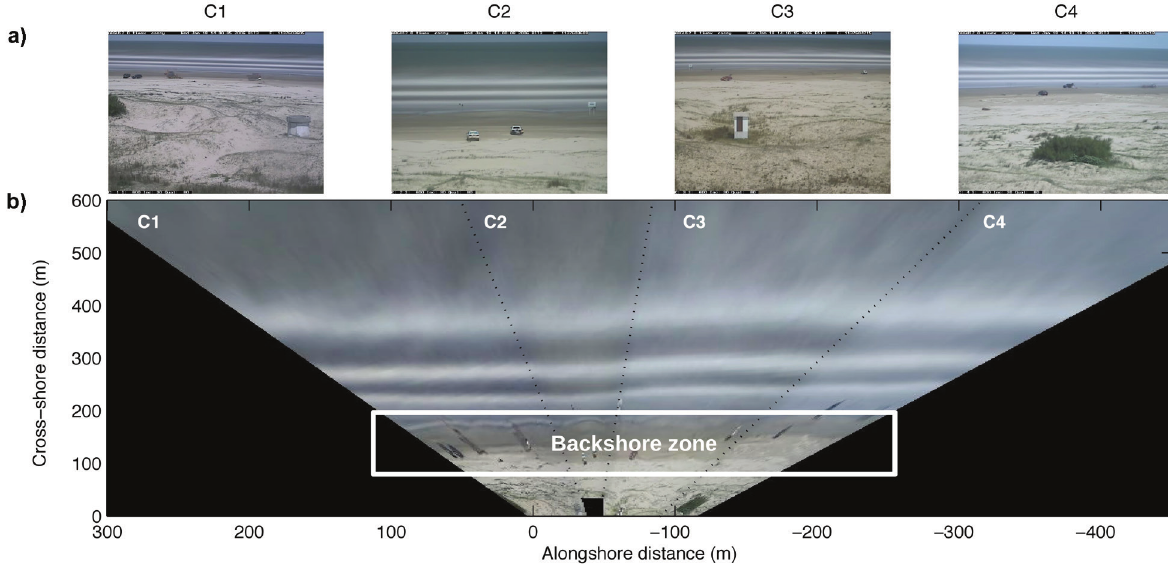
Figure 3 - a ) Example timex products from each Argus camera (C1, C2, C3, and C4) at Cassino Beach; b ) Rectified and merged timex images from the four cameras shown in (a). The backshore zone identified in the image exemplifies the study